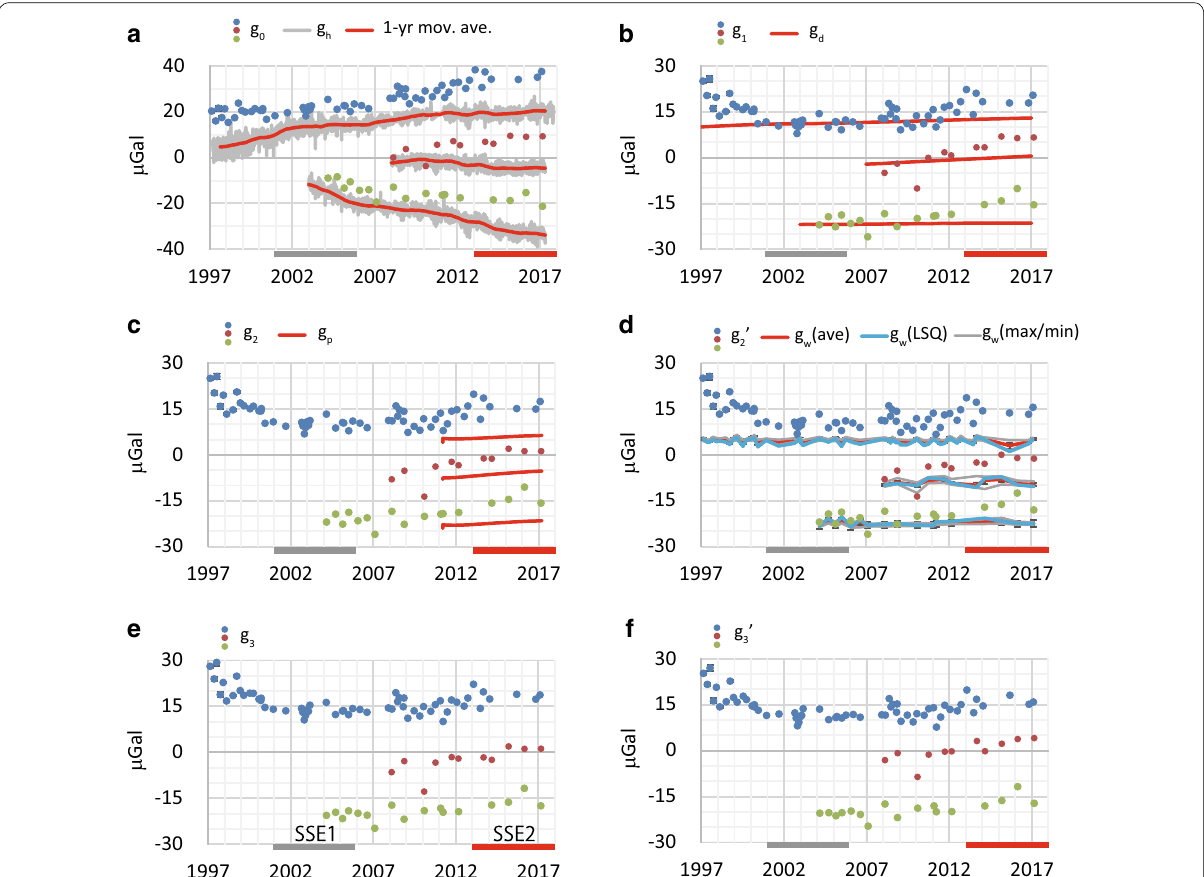
Fig. 2 The corrections of the gravity data. a The raw data ( g 0 ) at OMZ (blue), KKG (brown) and TYH (green) and the apparent effect caused by vertical displacements ( g h ). The gray and red bars denote the periods of the SSEs. b g 1 deficit and slow slip on the plate interface ( g d ). c g 2 g 2 ′ g 2 g p and the estimated groundwater noises. The blue lines represent the gravity change calculated from the soil parameters determined = − by the inversion ( g w (LSQ)). The red and gray lines, respectively, denote the average of the groundwater noises estimated for all the allowable parameters and the maximum and the minimum of them. e g 3